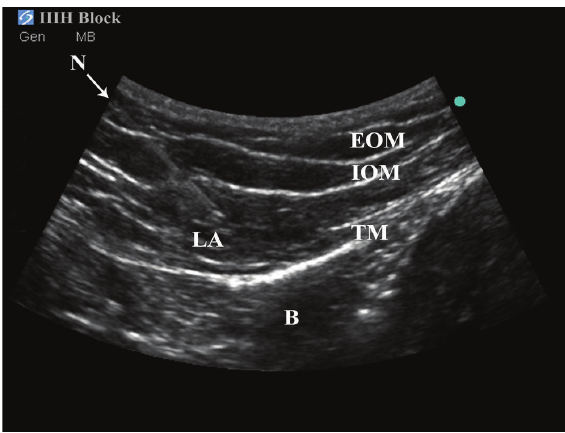
Figure 3: Sonographic anatomy of the US-guided IIIH block. N: needle, EOM: exterior oblique muscle, IOM: internal oblique mus- cle, TM: transversus muscle, LA: hypoechogenic local anesthetic pocket, B: